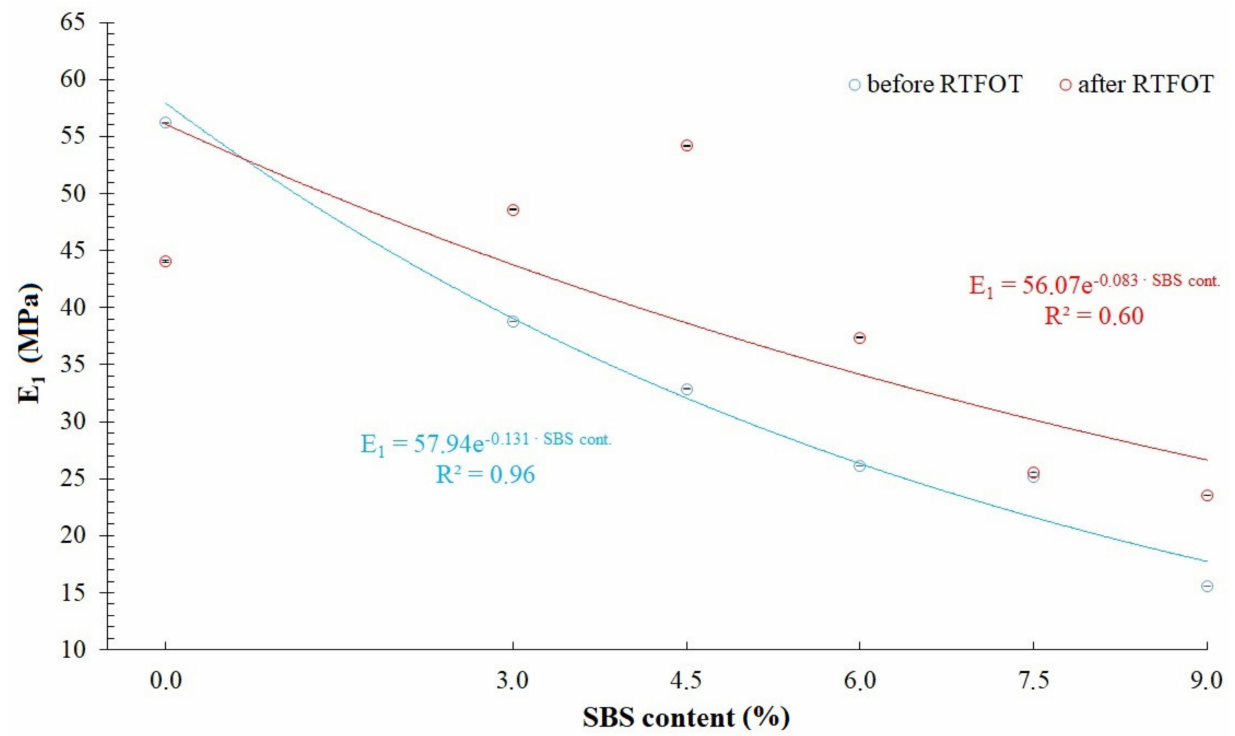
Figure 10. Values of modulus of elasticity (parameter E 1 ) in a modified generalized Maxwell model with four